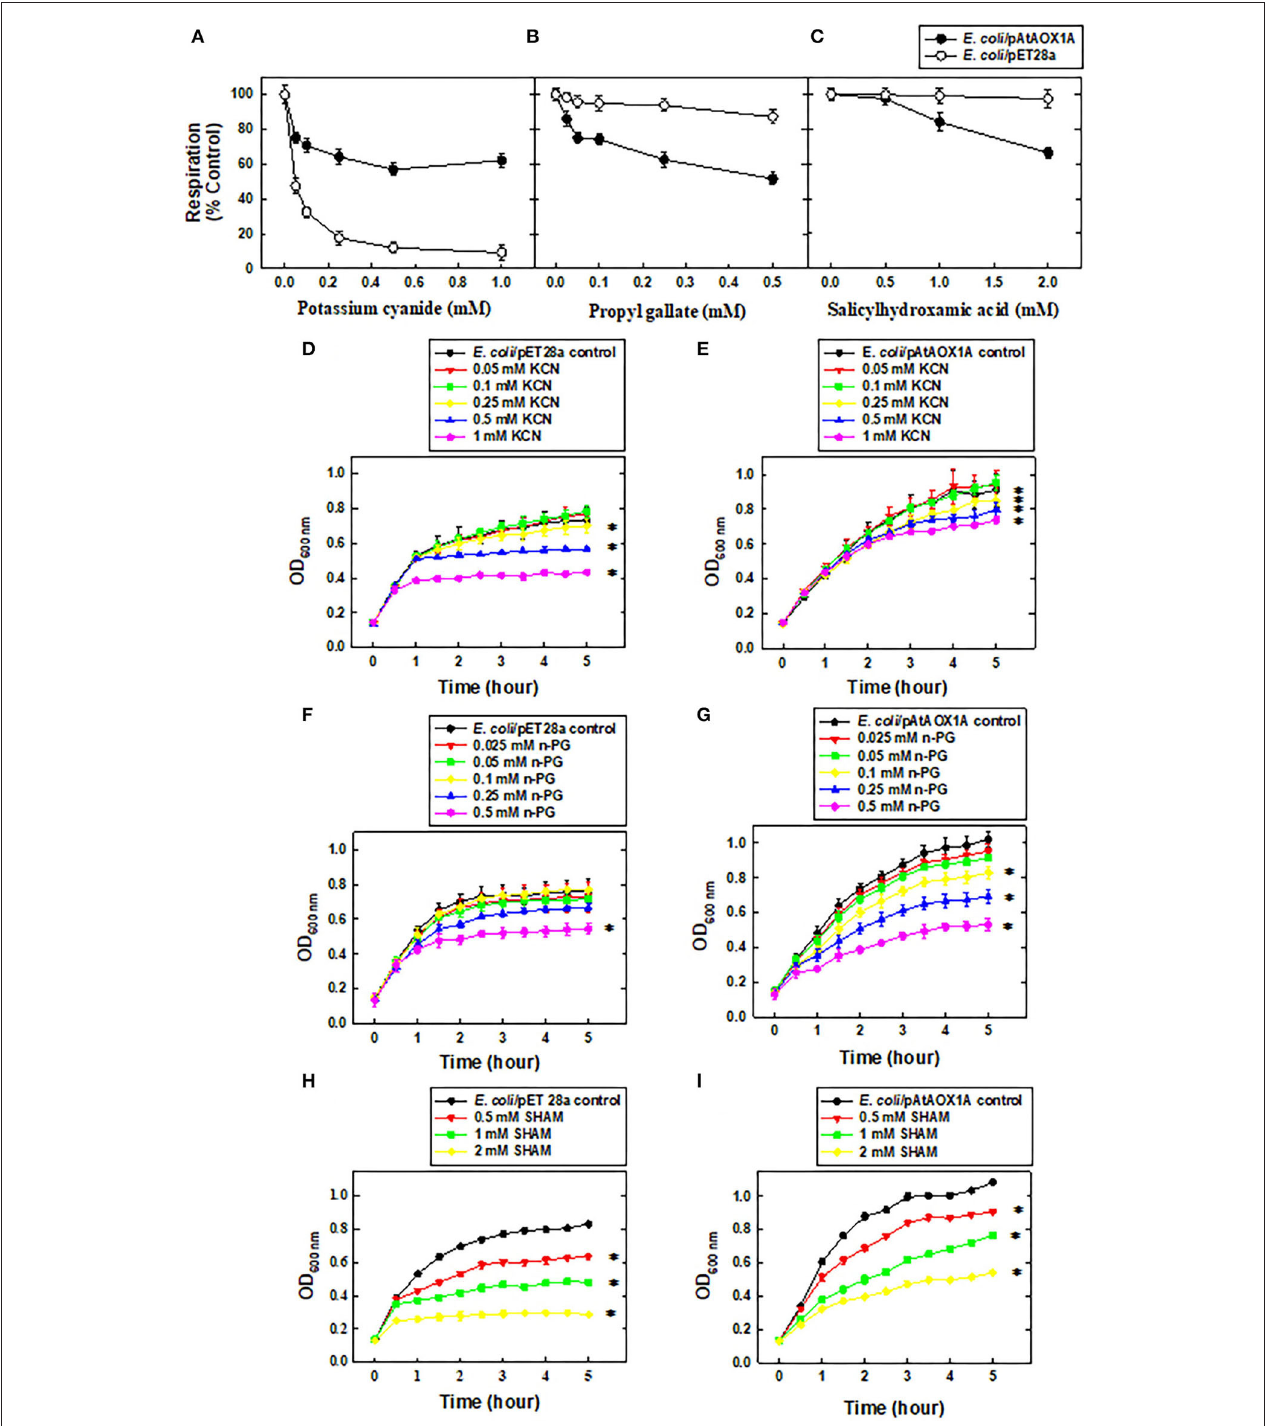
FIGURE 2 | Functional characterization of rAtAOX1A in E. coli . Oxygen uptake rates (%) of E. coli /pET28a and E. coli /pAtAOX1A in the absence or presence of respiratory inhibitors: (A) KCN (0.05, 0.1, 0.25, 0.5, and 1mM), (B) n-PG (0.025, 0.05, 0.1, 0.25, and 0.5mM), and (C) SHAM (0.5, 1, and 2mM). The growth pattern of E. coli cells was monitored for 5h in the absence or presence of respiratory inhibitors: (D) Growth pattern of E. coli /pET28a and (E) E. coli /pAtAOX1A in the absence or presence of KCN; (F) Growth pattern of E. coli /pET28a and (G) E. coli /pAtAOX1A in the absence or presence of n-PG; (H) Growth pattern of E. coli /pET28a and (I) E. coli /pAtAOX1A in the absence or presence of SHAM. Each value represents the mean ± SD of three experiments. The statistical significance difference ( P < 0.05) was calculated for the endpoint of the growth curve and indicated with asterisks.